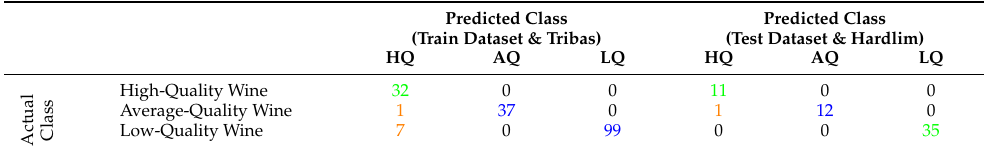
Table 13. Confusion matrices for the UMAP-ELM for dataset #2. Training set using the tribas activation function (left) and test set using the hardlim activation function